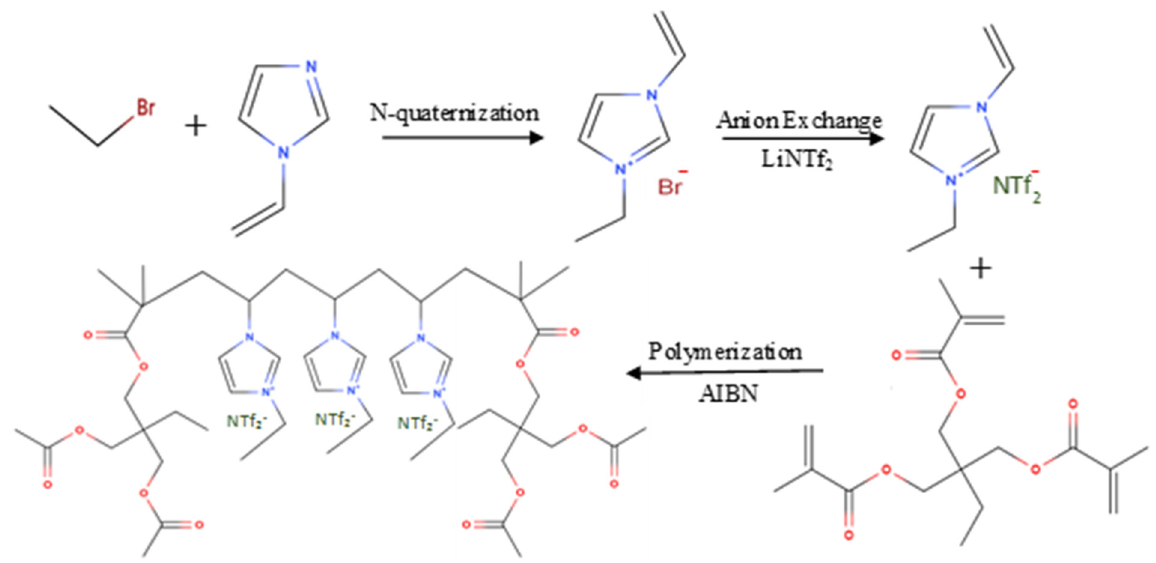
Figure 2. Schematic representation for the synthesis of poly[(veim)(Tf 2 N) − TRIM]. The FT-IR scanning of poly[veim][Br]-TRIM and poly[veim][Tf 2 N]-TRIM confirmed